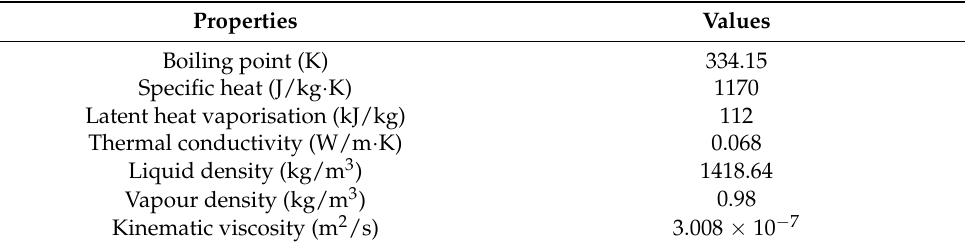
Table 2. Properties of HFE-7100